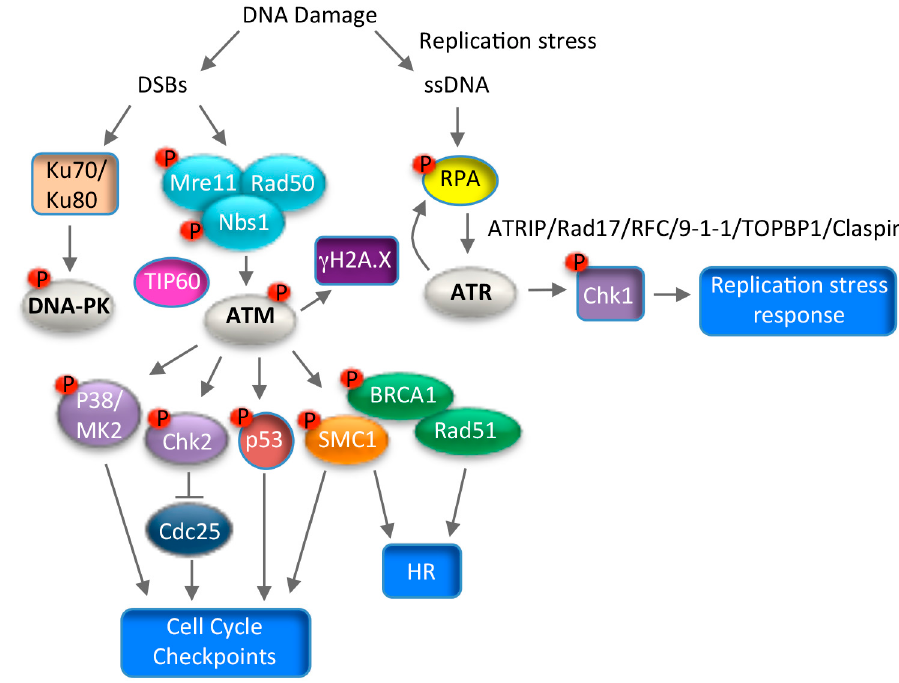
Figure 4. Schematic of the Ataxia-Telangiectasia Mutated (ATM), DNA-dependent Protein Kinase (DNA-PK), and ATM and Rad3-related (ATR) DNA damage response pathways. ATM and DNA-PK are activated in response to double strand DNA breaks (DSBs). ATM facilitates DNA repair through high-fidelity homologous recombination (HR), however, DNA-PK promotes repair through error-prone non-homologous end joining (NHEJ). DNA-PK is activated by the DNA damage sensor complex of Ku70/Ku80, while ATM is activated by the DNA damage sensor complex MRN (Mre11, Rad50, Nbs1) and the TIP60 acetyltransferase. ATM phosphorylates numerous downstream effectors, including H2A.X (gH2AX), Chk2, p38, p53, SMC1 and Breast Cancer Gene 1 (BRCA1) to induce cell cycle arrest and facilitate DNA repair, or to promote apoptosis in the case of severe DNA damage. ATR is activated by single-stranded DNA (ssDNA) generated by replication stress or the resection of DSBs. ssDNA is protected by the tripartite complex RPA, which promotes ATR activation through recruitment of ATRIP, a critical ATR regulator. The Rad17/RFC complex also binds to RPA-coated ssDNA and loads the 9-1-1 complex (Rad9-Hus1-Rad1). 9-1-1 recruits TOPBP1, which is necessary for ATR activation. Claspin mediates the activation of Chk1 by ATR, leading to the replication stress response. T bars indicates inhibition. Arrows indicate activation.